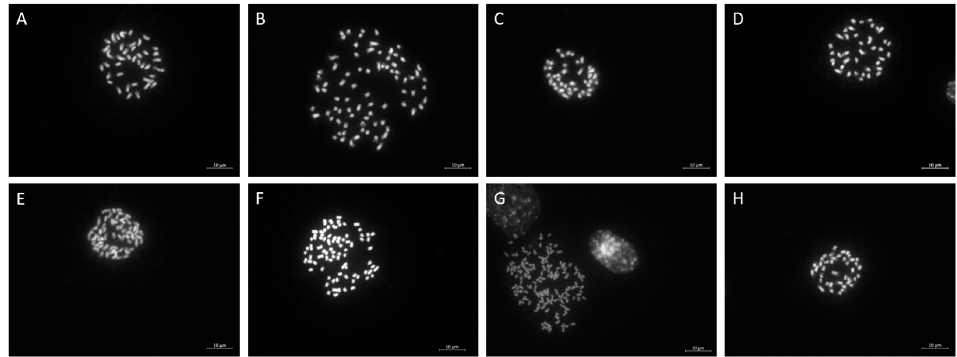
Figure 3. Fluorescence microscopy images of stained nuclei reveal chromosome numbers of Ilex